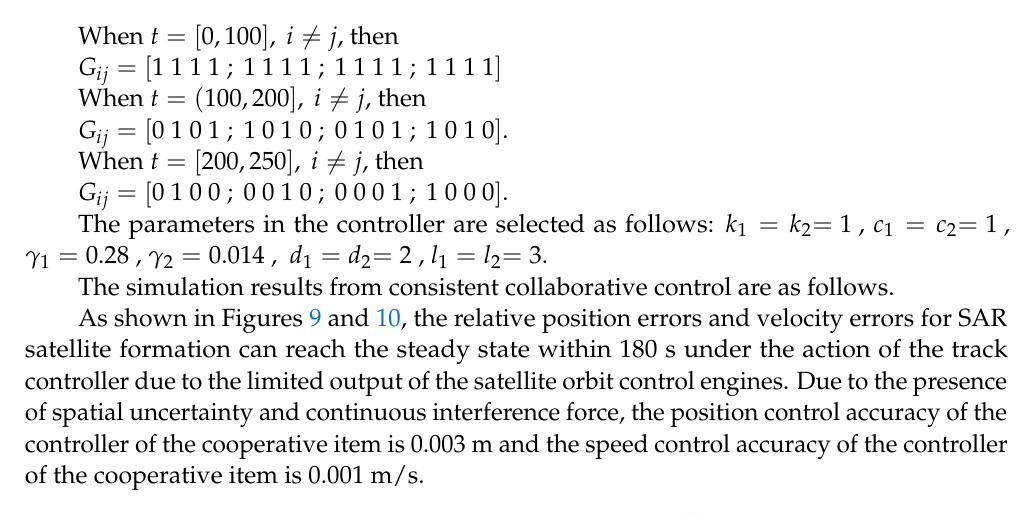
15 of 21 Figure 8. S1, S2, S3, S4 control torque for non-consistent collaborative control. Case 2: Verify the performance of hierarchical saturated consistent collaborative con- troller under time-varying delay and switching topology. Assuming that the communication network is stable and the delay matrix between satellites is a variable value, the delay matrix is set as: ij